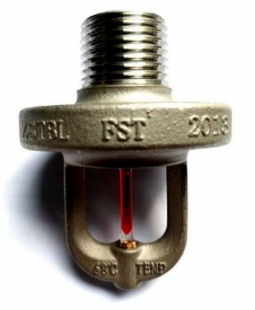
Figure 2. Window